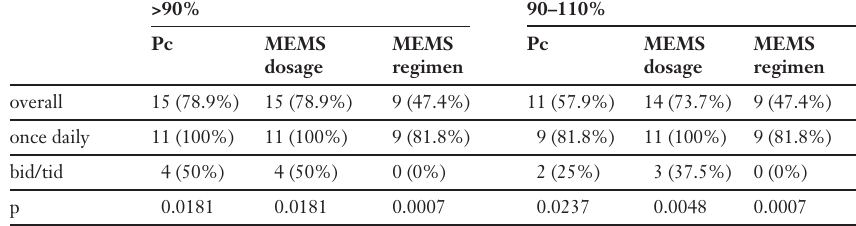
Proportion of compliers using different meth- ods to measure (Pc, MEMS d , MEMS r ) and define (A: adherence rate >90%; B: adherence rate 90–110%) adherence. Comparison